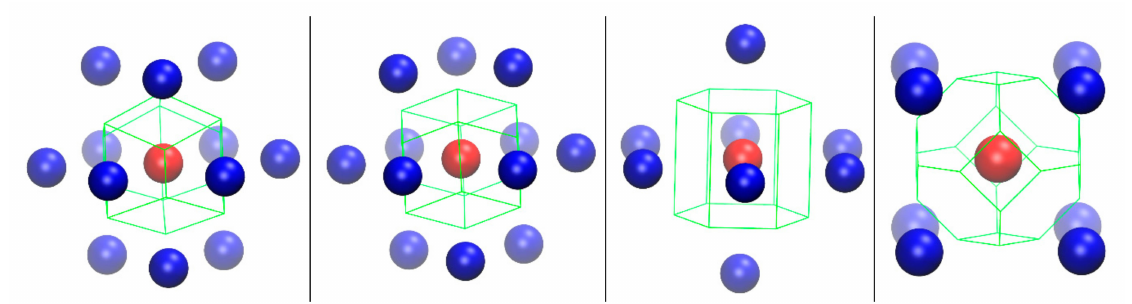
Figure 3. Voronoi polyhedron and nearest neighbors for a given site (red) in the 3-D reference crystals. From left to right: HCP, FCC, HEX and BCC. Voronoi edges are shown as green lines, and tangent neighbor sites in blue. Sphere radii have been reduced by 2:5 for visualization purposes. Image created with the VMD software. Each figure panel is also available as stand-alone image in 3-D, interactive format in the Supplementary Material.